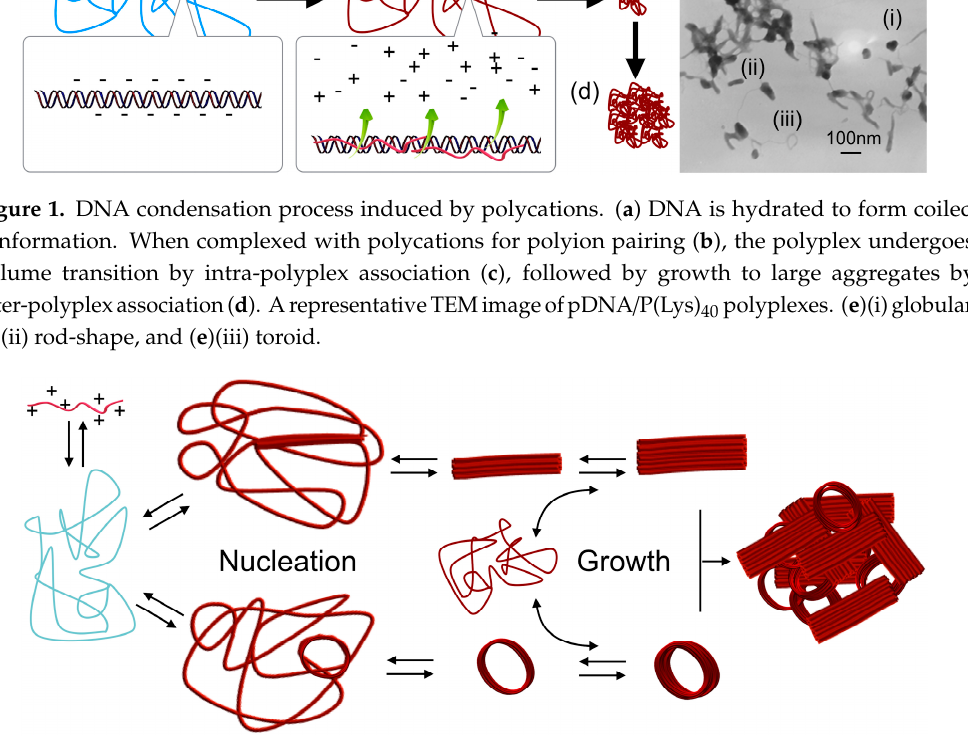
Figure 2. Possible scheme of DNA condensation process based on nucleation and growth for polyplexes of low molecular weight